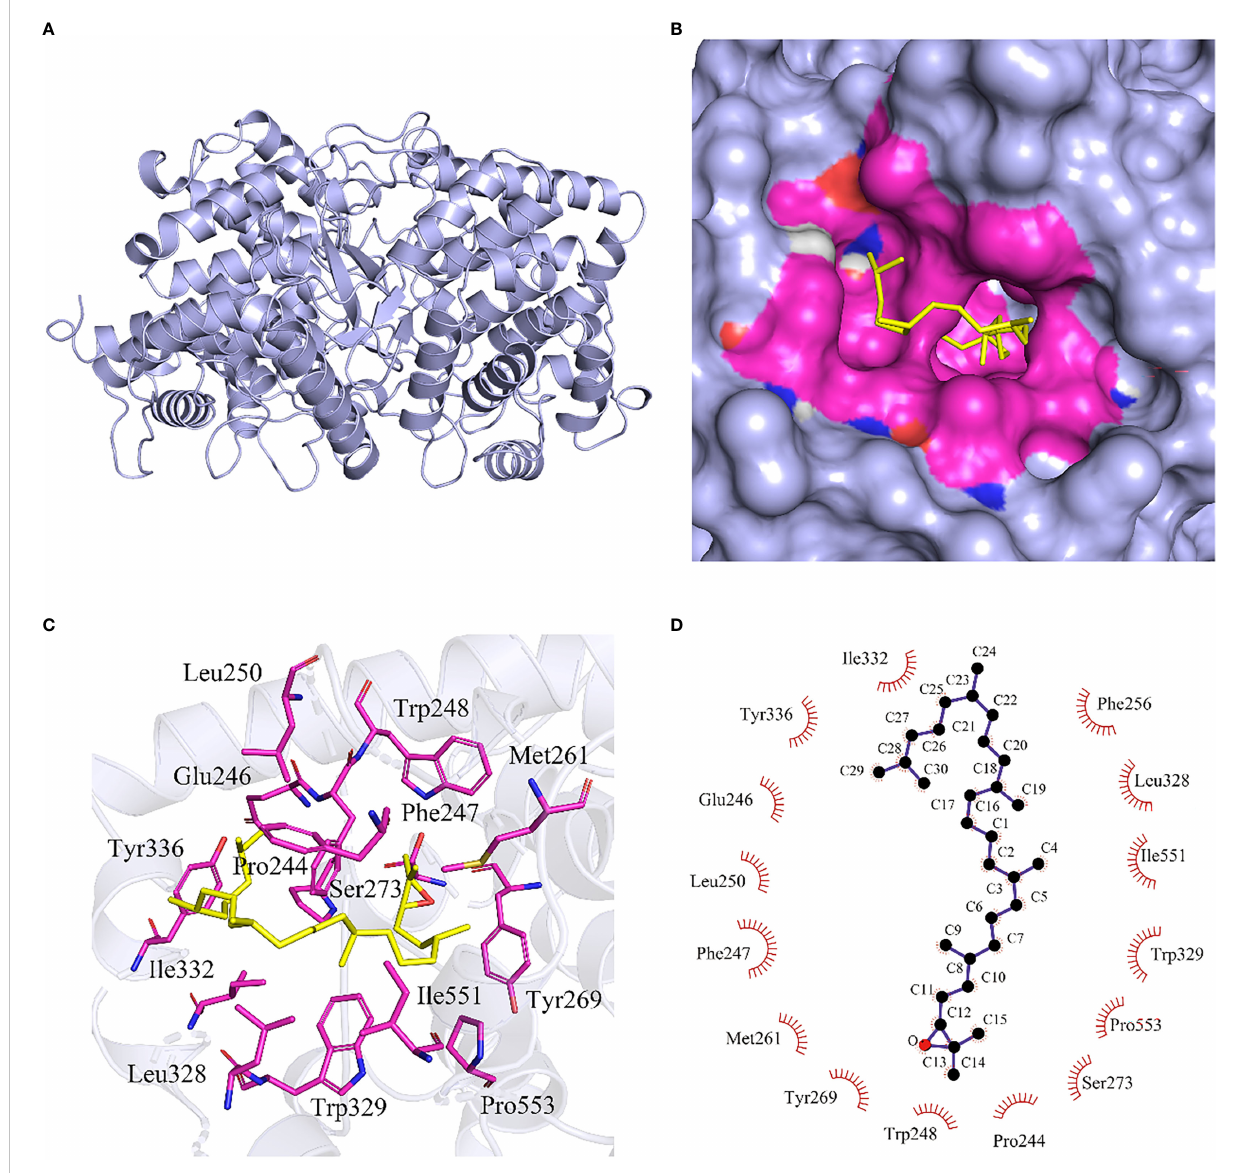
FIGURE 2 Molecular docking of 2,3-oxidosqualene to DNA binding site of HcOSC6. (A) The HcOSC6 nucleotide sequence was translated into protein sequence, highly accurate protein structure prediction with AlphaFold2, save its PDB fi le and visualize it using PyMOL software, and the predicted three- dimensional (3D) protein colored light purple is shown in cartoon representation. (B) Surface model representing the interacting site HcOSC6 with 2,3-oxidosqualene. The protein-colored light purple is shown in surface representation. The 2,3-oxidosqualene binding site containing interacting residues colored differently is in surface representation. The bound 2,3-oxidosqualene in stick representation colored blue with oxygen and hydrogen atoms colored red and white, respectively. Yellow color represented ligand and rosy color represented interacting amino acids. (C) Protein-ligand interaction plot of 2,3-oxidosqualene bound to HcOSC6. The magenta stick indicated the amino acid residue that interacts with the 2,3-oxidosqualene at a distance of 4Å, and hydrophobic bonds were formed between the amino acid residues and the ligand. (D) Two-dimensional surface representation of the binding of 2,3-oxidosqualene and key residues with hydrophobic interaction. The 2,3-oxidosqualene was shown in ball-and-stick representation. The black balls showed carbon atoms whereas the red balls showed the oxygen atoms. The residues involved in non-bonding interactions were shown as red bristles. The 2,3-oxidosqualene had hydrophobic interactions with I332, Y336, E246, L250, F247, M261, Y269, W248, P244, S273, P553, W329, I551, L328 and